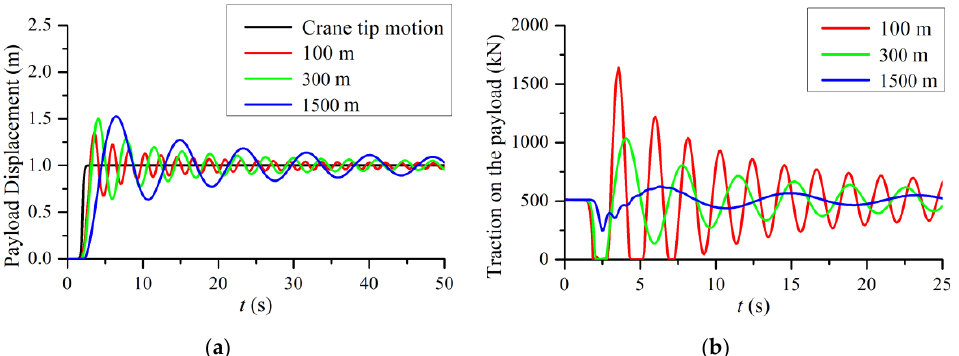
Figure 9. System response under a rapid downwards crane tip motion for different lowered depths: ( a ) payload motion; ( b ) force on the payload.